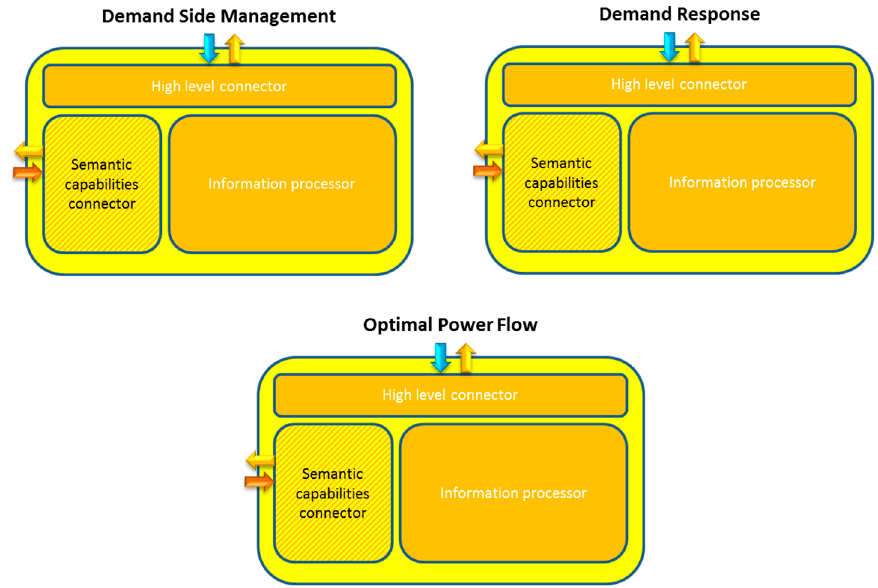
Figure 10. Data processing in distributed energy services.